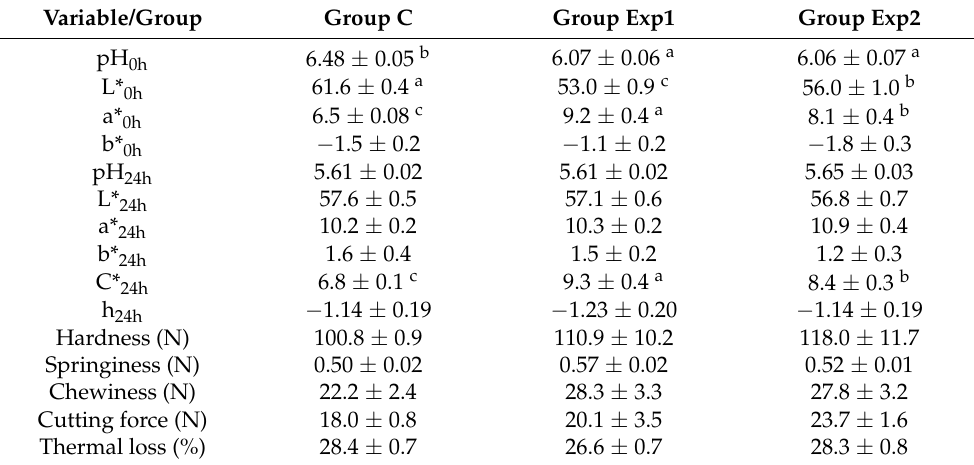
Table 5. Physical properties of pectoralis major muscles in organic turkeys receiving three differ- ent